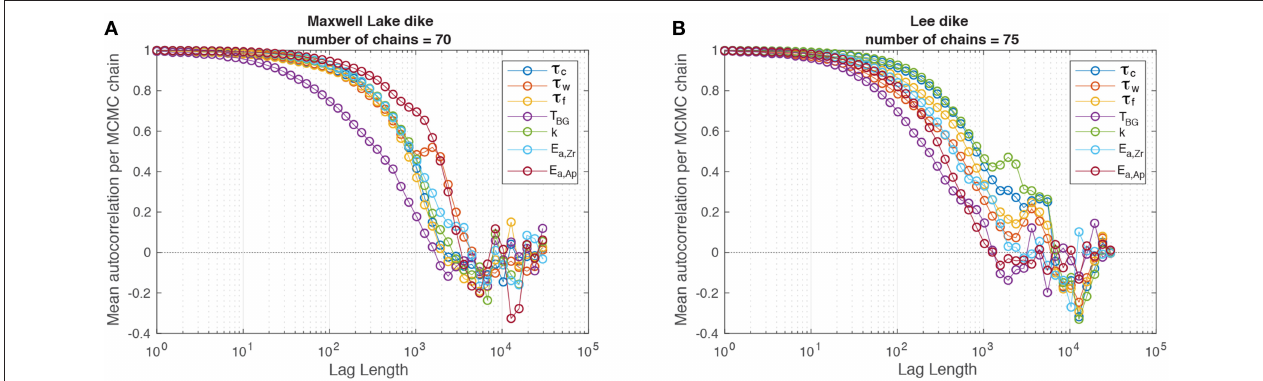
FIGURE A1 | (A) Average autocorrelation of MCMC chains as a function of lag for the Maxwell Lake dike, for each parameter. Autocorrelation is calculated for each of 70 chains with randomized starting points, then averaged at each lag value to produce these curves. (B) Same as (A) for the Lee dike MCMC simulations, with 75 independent chains